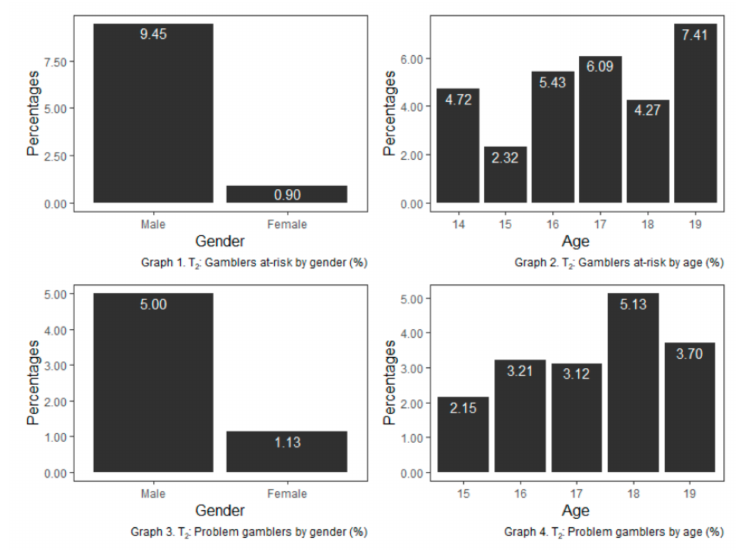
Figure 3. At-risk and problem gamblers by age and gender (%) for T 2 . The percentage refers to both the percentage of total males or females who are classified as a risk ( n = 116) or problem gambler ( n = 70) and the percentage of total youths of each age who are classified as a risk or problem gambler.